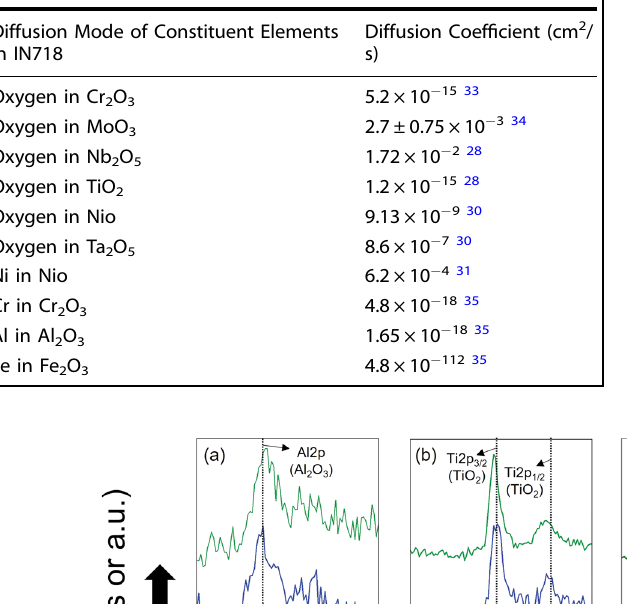
Table 1. Diffusion modes of constituent elements of IN718 and corresponding diffusion coef fi cients 19,25,28,30,31,33 – 35